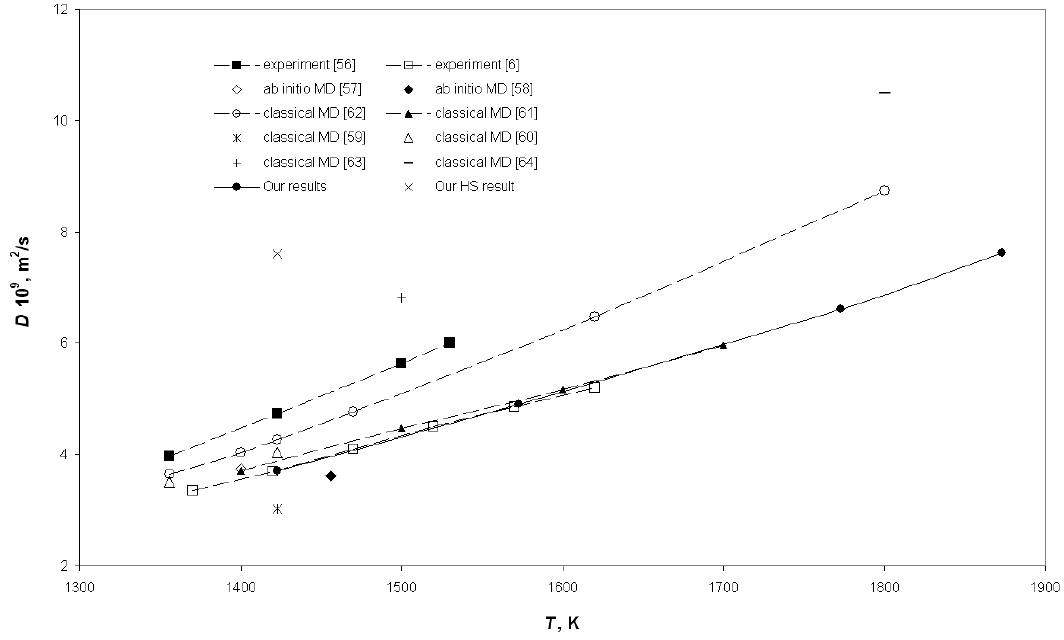
Figure 1. Self-di ff usion coe ffi cient of liquid Figure 1. Self-diffusion coefficient of liquid Cu.